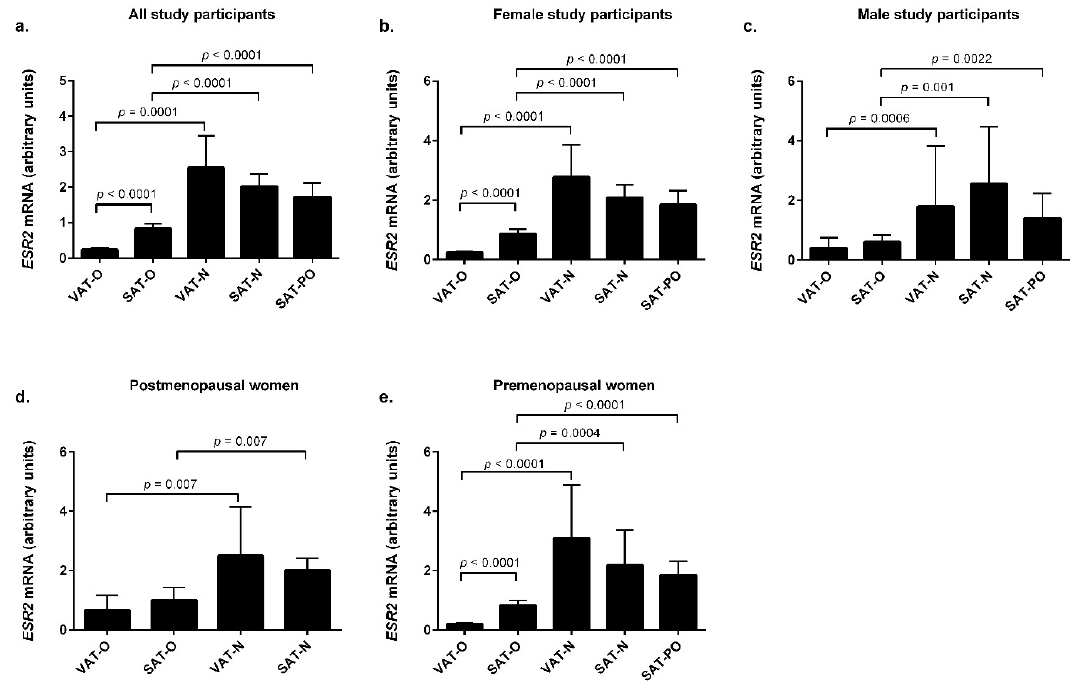
Figure 2. ESR2 mRNA levels in the visceral (VAT) and subcutaneous (SAT) adipose tissues of obese individuals before (O) and after surgically induced weight loss (PO) and in normal-weight subjects (N). Results are presented as the median with the interquartile range for the whole group ( a ), women ( b ), men ( c ), postmenopausal women ( d ), and premenopausal women ( e ).